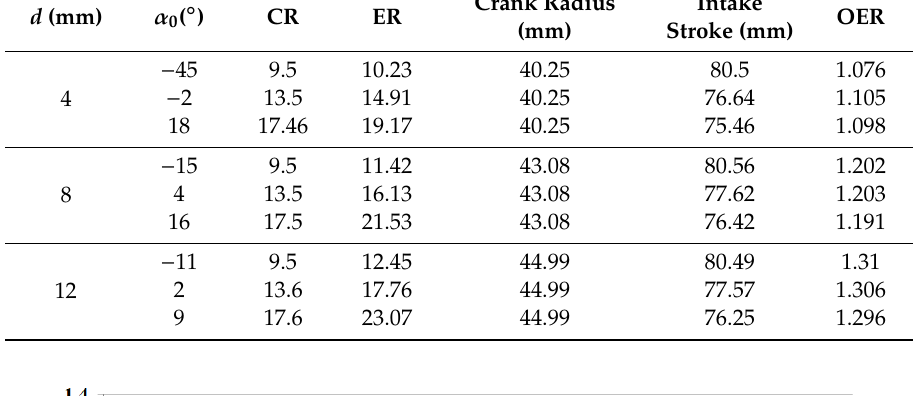
Table 1. Parameters of the DSC-VCR with different (eccentric size) d values.